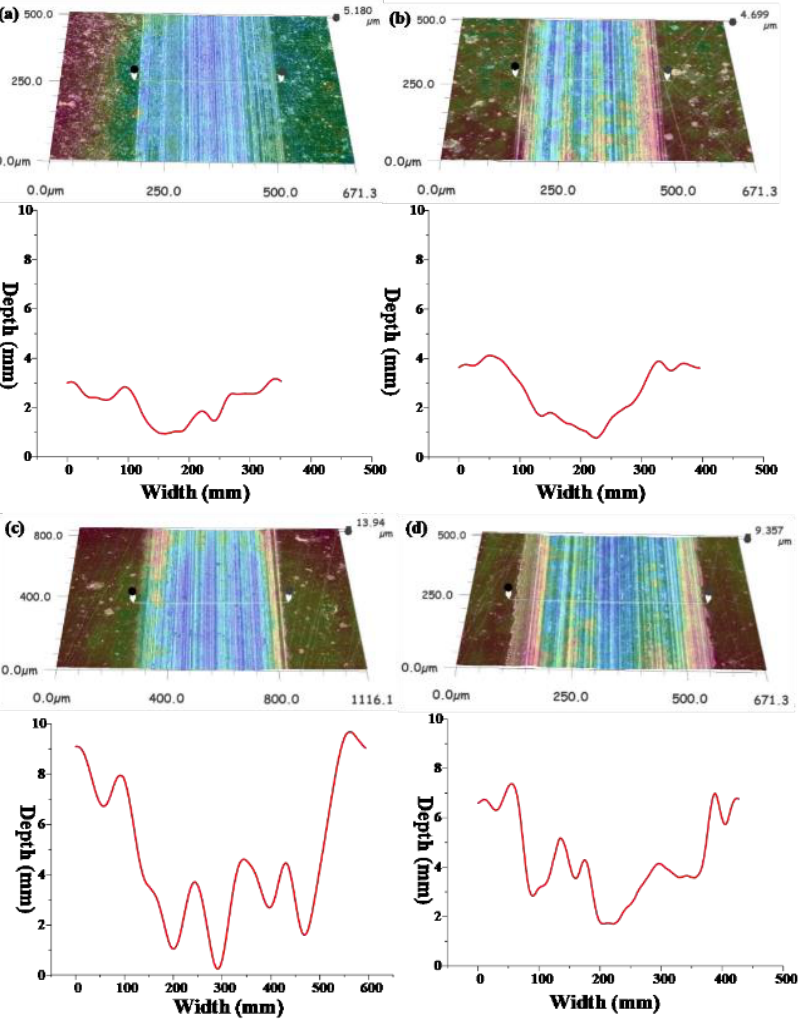
Figure 6. Three-dimensional morphologies and wear tracks of the wear scars corresponding to sample oil #1 under four different loads at the same sliding velocity: ( a ) 20; ( b ) 60; ( c ) 100; ( d ) 120 N.